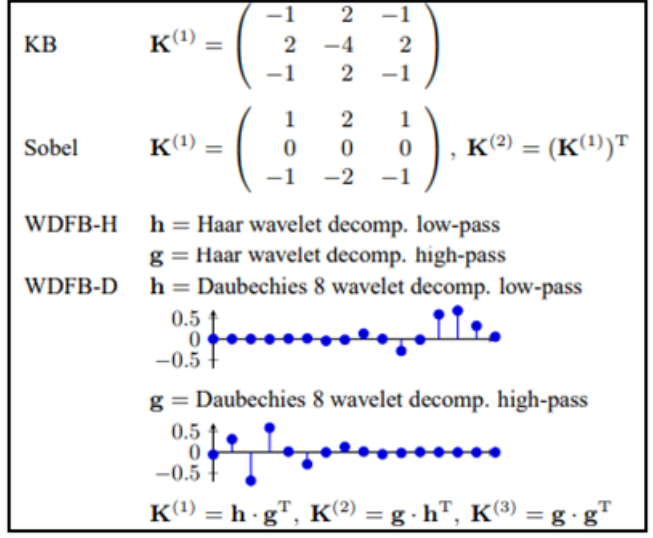
Figure 2. HPFs and wavelet filters used in WOW [9].